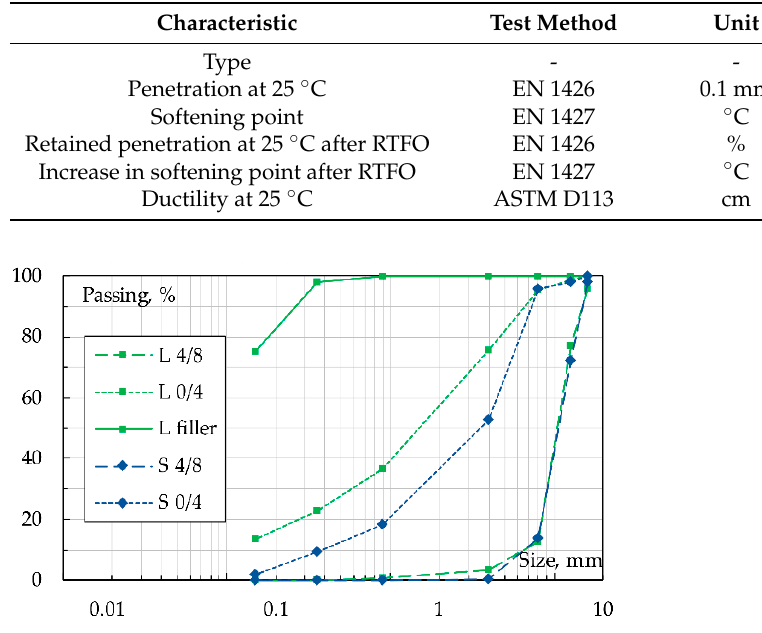
Figure 2. Available stockpiles for the selected aggregates: limestone ( L ) and steel slag ( S ).